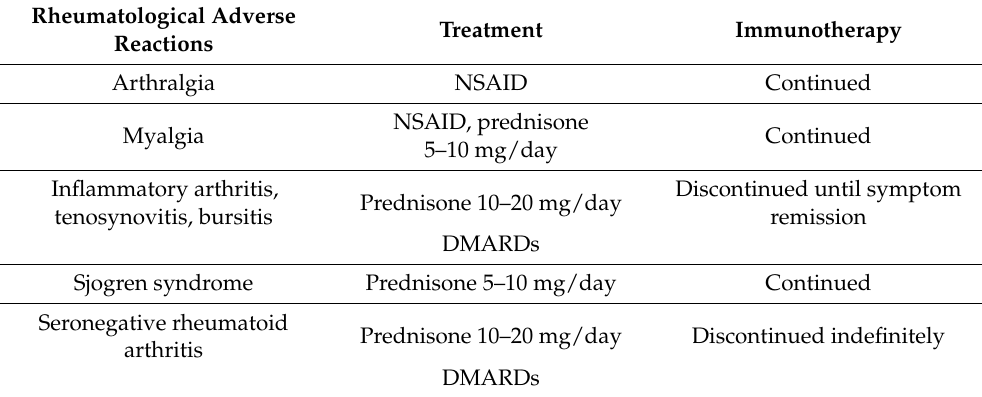
Table 2. Rheumatological adverse events secondary to immunotherapy, treatment, and management. Rheumatological Adverse